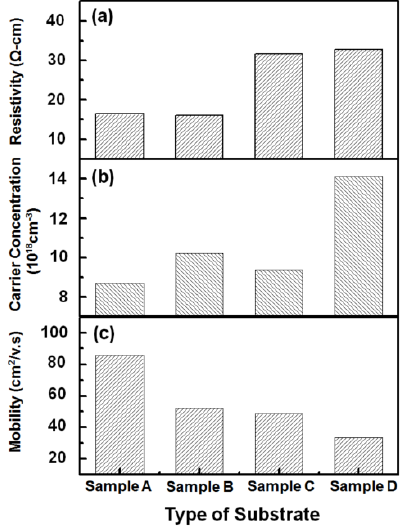
Figure 5. Variation in ( a ) resistivity; ( b ) carrier concentration; and ( c ) mobility of GaN films with different substrates.